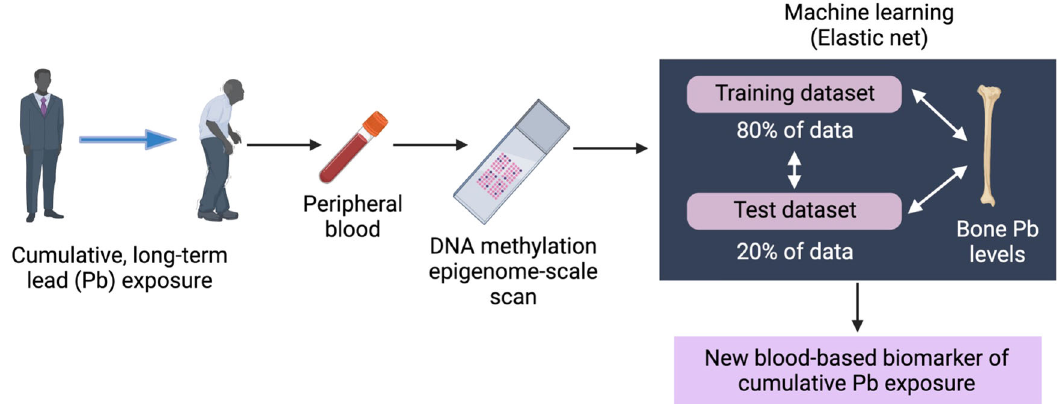
Fig. 4 | Use of epigenetic data and machine learning to develop a new blood- based biomarker ofcumulative lead (Pb) exposure in the Boston area Veteran Affairs Normative Aging Study 1 . Epigenome-scale blood methylation data were used to trainand test against benchmark bone-Pbdata,whichre fl ectlong-termPb